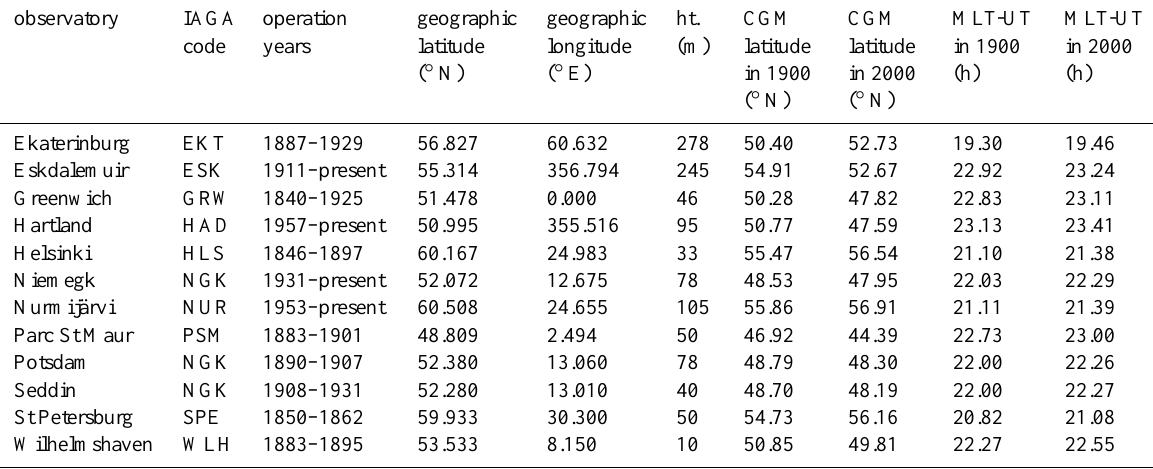
Table 1. Long-term and historic geomagnetic observatories employed in this study.